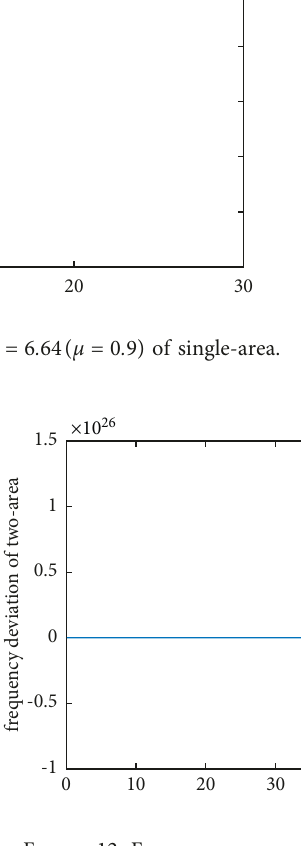
Figure 12: Frequency responses with h � 7 of two